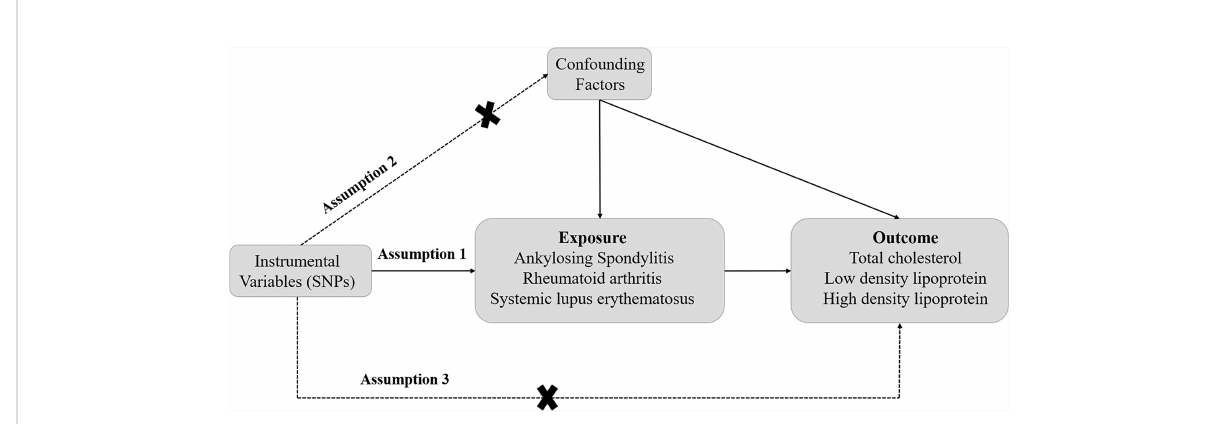
FIGURE 1 The schematic diagram of Mendelian randomization (MR). Three assumptions should be met, as follows: Assumption 1: The SNPs should be closely related to exposures; Assumption 2: The IVs selected are supposed to be independent of confounders; Assumption 3: SNPs should in fl uence the outcomes just through the exposure. (IVs, instrumental variables; SNPs, single-nucleotide